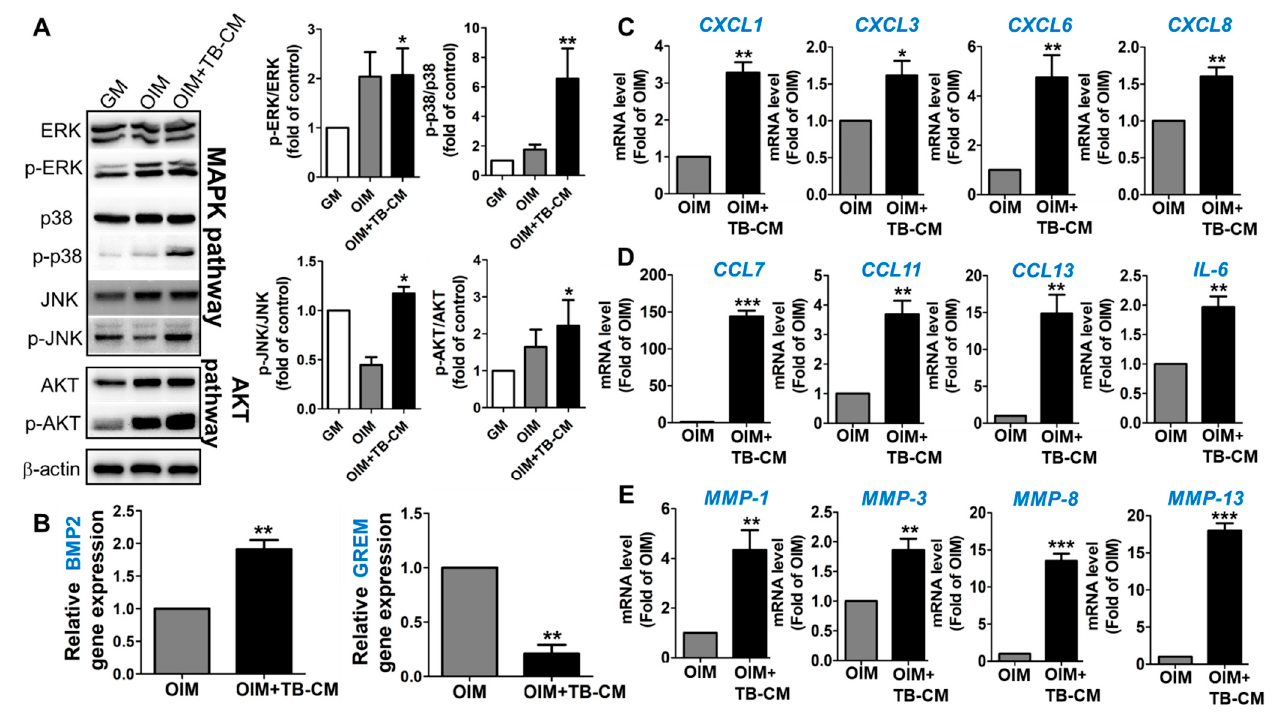
Figure 5. TB-CM induces significant transcriptome alteration in HNDF cells during migration. ( A ) Proteins associated with the MAPK pathway, such as ERK, p-ERK, p38, p-p38, JNK, and p-JNK, were evaluated for their expression levels in the TB-CM-treated mesenchymal stem cells (MSCs) by performing western blot analysis. The expression levels AKT and p-AKT in MSCs treated with TB-CM were also detected using western blot analysis. A quantitative analysis of the western blot was performed, which showed significant expression levels of protein, as presented in the histogram. p -values were obtained using a t -test, compared to that of the GM group. ( B ) The relative expression levels of BMP2 and GREM1 encoding genes were analyzed both in the TB-CM-treated and control MSCs. A reverse transcription-polymerase chain reaction was performed to confirm the increase in the expression levels of CXCL ( C )-, CCL ( D )-, and MMP ( E )-associated genes in the TB-CM-treated MSCs. Data have been indicated as mean ± SD; * p < 0.05, ** p < 0.01, and *** p < 0.001, compared to the corresponding control.